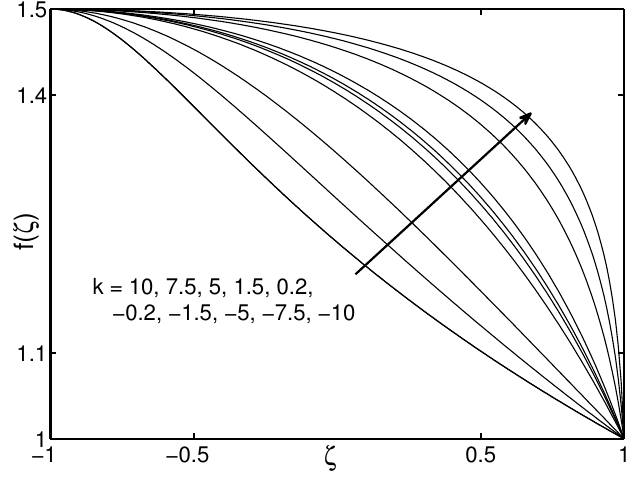
Figure 1. The graph of f ( ξ ) given by Equation (24) as k near